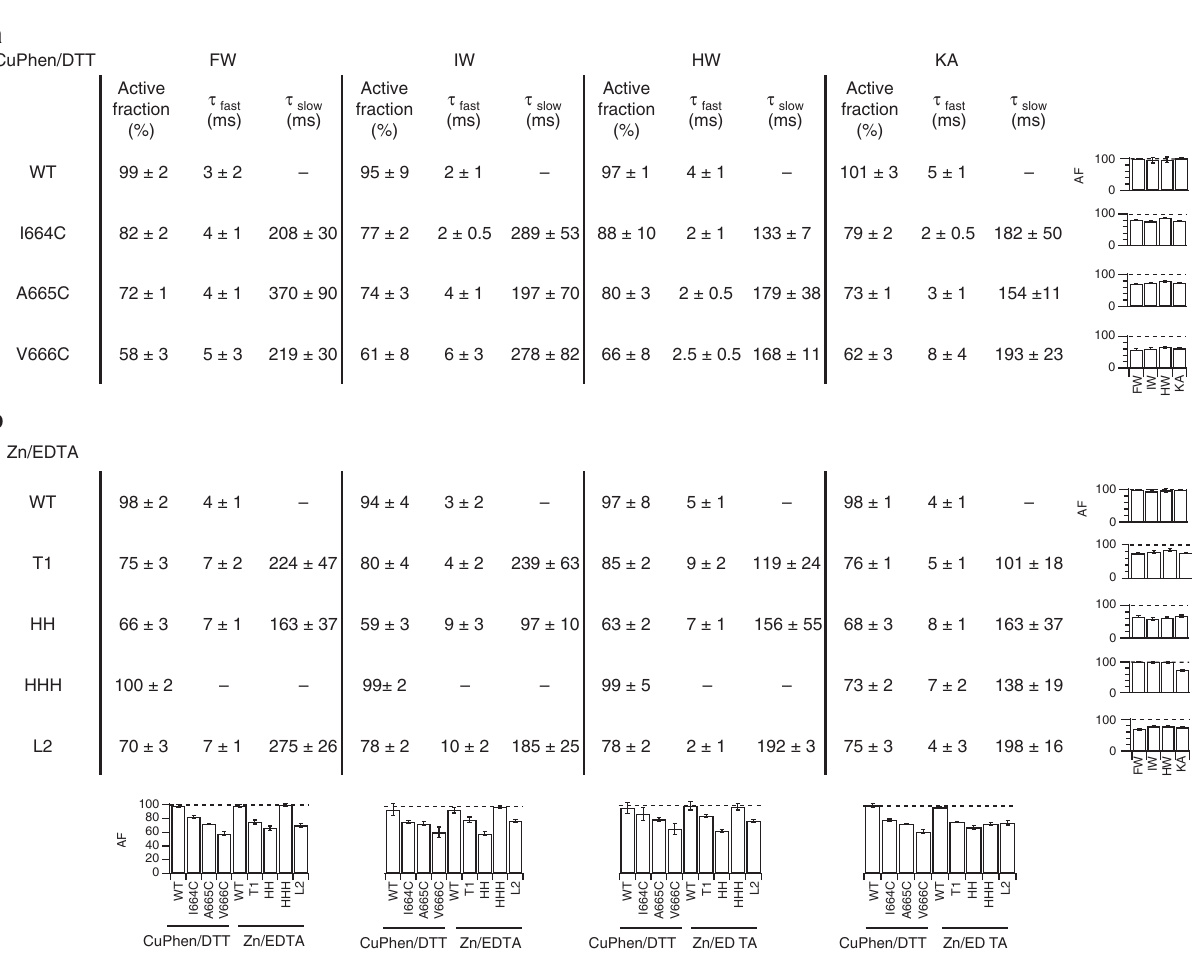
Figure 5 | Summary of current recovery after trapping. ( a ) The reduction of the active fraction and the time constants obtained from the double exponential fitting to the current during the recuperation after trapping ( t fast and t slow ) for cysteine mutants (for their locations, see Fig. 3). The fast time constant corresponds to glutamate activation, and the slow component is assumed to correspond to the breaking of the trapping bridge. ( b ) Equivalent data for histidine mutants (for their locations, see Figs 1 and 4). The graphs at the base of each column show the active fraction from all of the mutants versus the different partial agonist. The row end graphs show the individual mutants versus the different partial agonists. All errors are s.e.m., and for all data columns, n ¼ 5